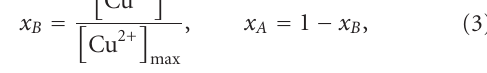
Table 2: Binding parameters for A β (1–16) + Cu 2+ interaction. Neg- ative δ θ A and δ θ B values indicate that Cu 2+ could a ff ect the structure of A β (1–16) and destabilize the A β (1–16) structure significantly. Unstable A β (1–16) + Cu 2+ complex causes the aggregation of A β (1– 16) in the